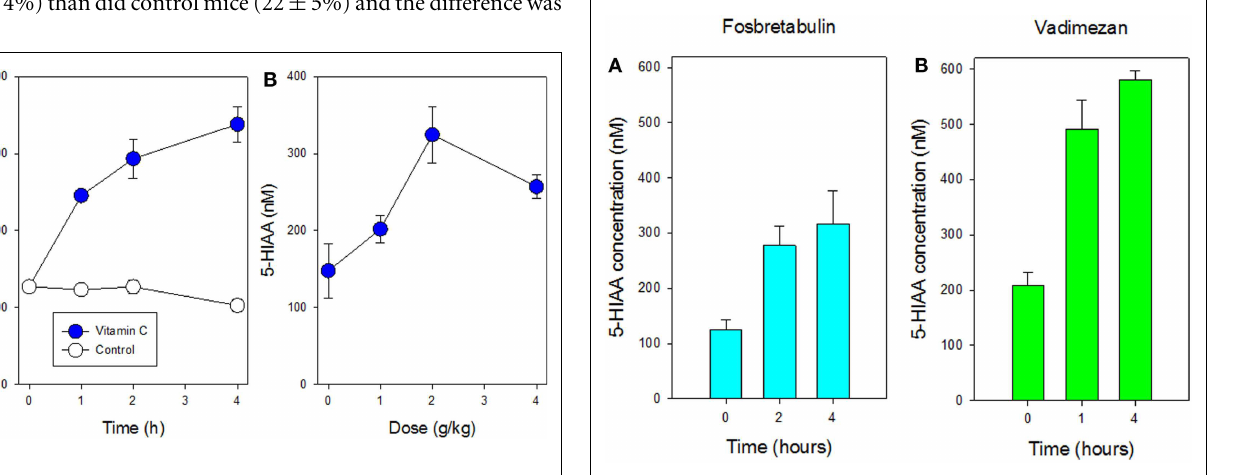
FIGURE 1 | Plasma concentrations of 5-HIAA following a single i.p. administration of vitamin C are shown . (A) Time course for non-tumor-bearing mice following administration of vitamin C (5g/kg; filled circles) or with no treatment (open circles). (B) Dose curve for non-tumor-bearing mice following administration of vitamin C (0–4g/kg). Vertical bars in each case represent SEM.